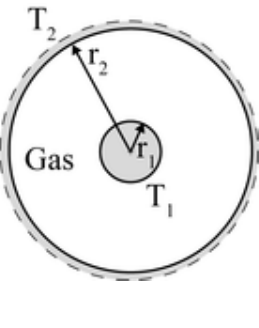
Figure 3. Cylindrical model